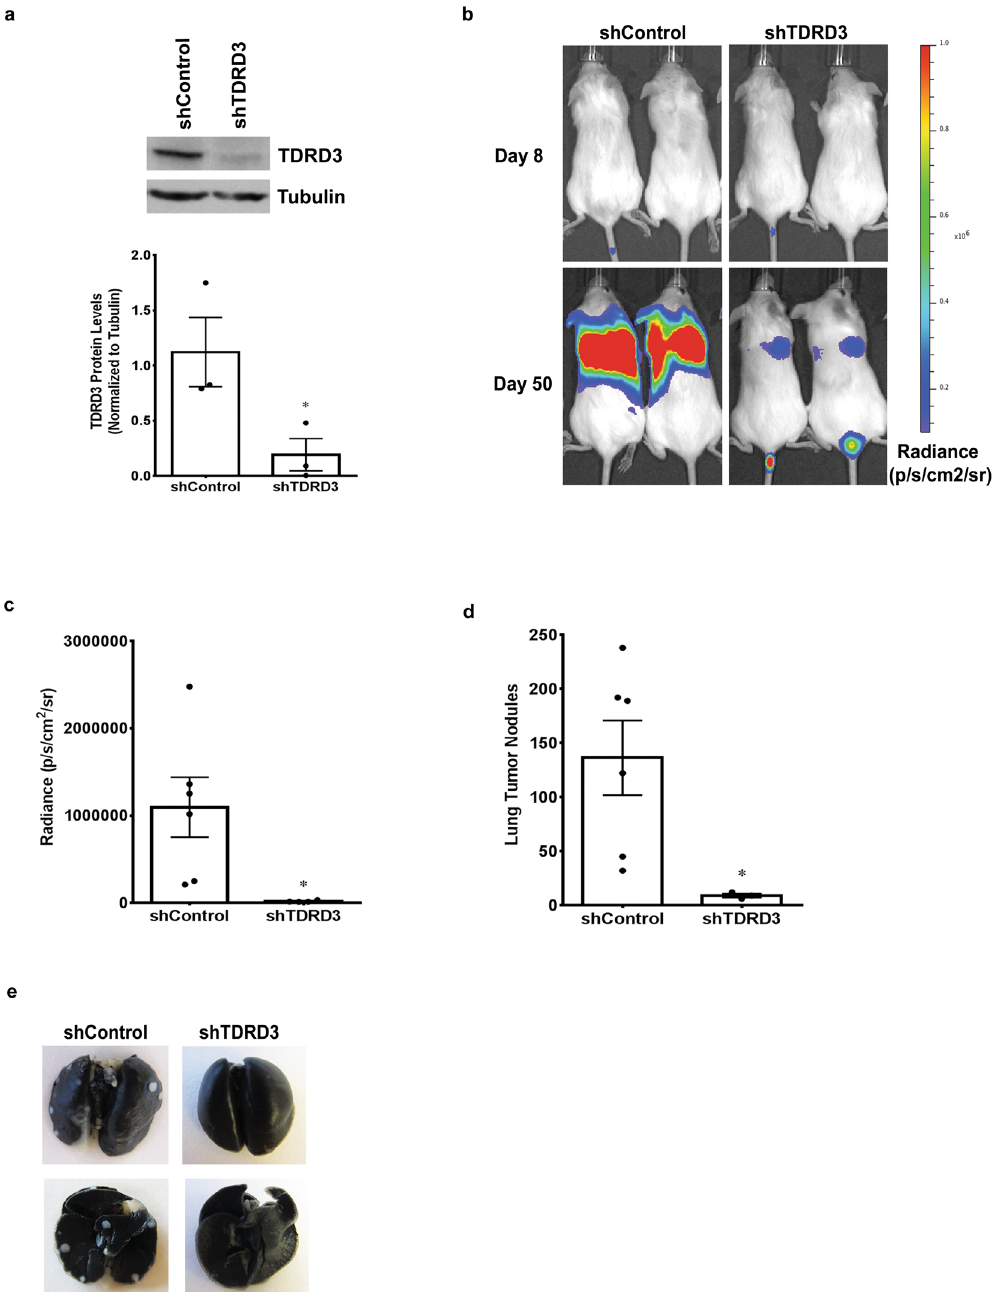
Figure 4. TDRD3 Promotes Metastasis, In Vivo . Six-week-old female NOD.CB17-Prkdcscid/JSCID mice were injected with MDA MB 231 shTDRD3 and luciferase or shControl and luciferase expressing cells. ( a ) TDRD3 protein levels, mean ± SEM (n = 3, * p = 0.0274) ( b ) Luciferase intensity was measured using the IVIS spectrum imaging system. Representative images show bioluminescence from shControl and shTDRD3 cells. ( c ) Average radiance (p/s/cm 2 /sr) of shControl (n = 6) and shTDRD3 (n = 4) injected mice ( * p = 0.018). ( d ) Lung tumor nodule formation depicting the mean ± SEM for shControl (n = 6) and shTDRD3 (n = 4) mice ( * p = 0.0198). ( e ) Images showing the anterior (upper image) and posterior (lower image) lung surface in shControl and shTDRD3 mice. Significance was determined using a two-tailed t